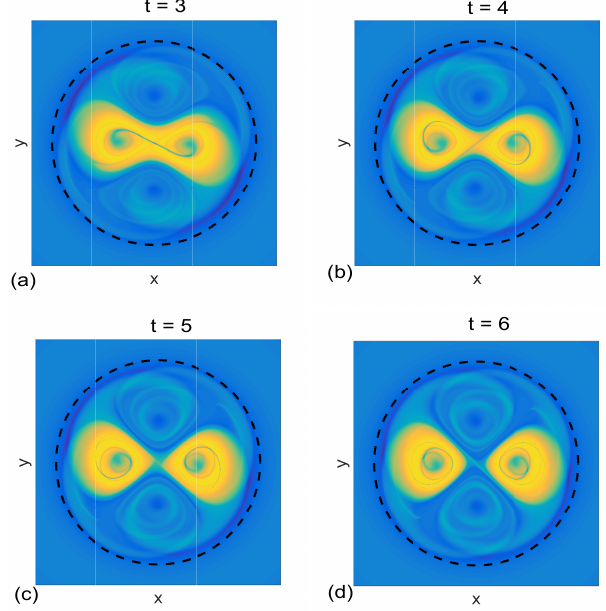
Figure 7. Lagrangian patterns obtained at t = 0 for τ = 15 and dif- ferent parameter settings in the kinematic model. (a) Fourier com- ponents (cid:57) 0 and (cid:57) 2 with the latter adjusted to perturb the vortex in its outer part; (b) Fourier components (cid:57) 0 and (cid:57) 1 with the latter ad- justed to perturb the vortex in its outer part; (c) the model keeps (cid:57) 0 , (cid:57) 1 and (cid:57) 2 ; (d) the model keeps (cid:57) 0 , (cid:57) 1 and (cid:57) 2 with parameters adjusted differently to (c) .